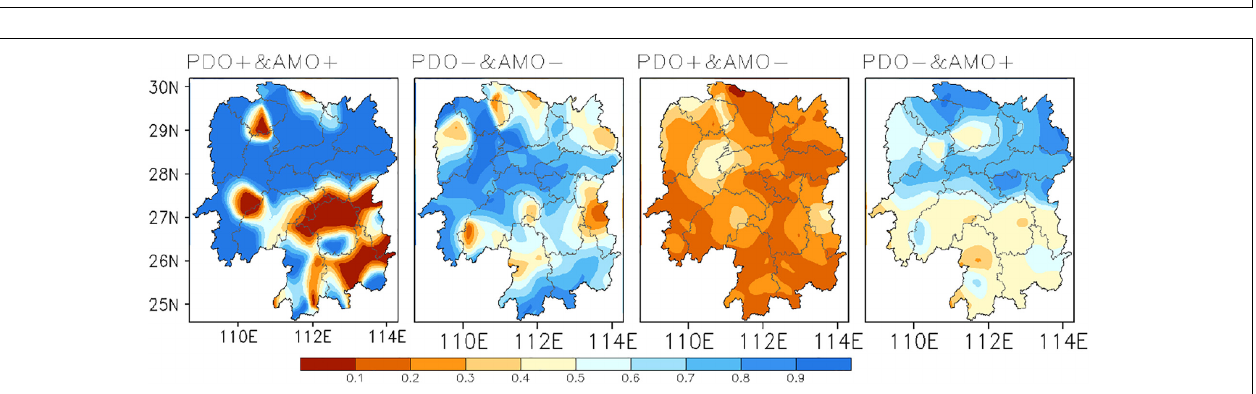
FIGURE 5 | The same as Figure 4 , but for the next years of El Niño events.